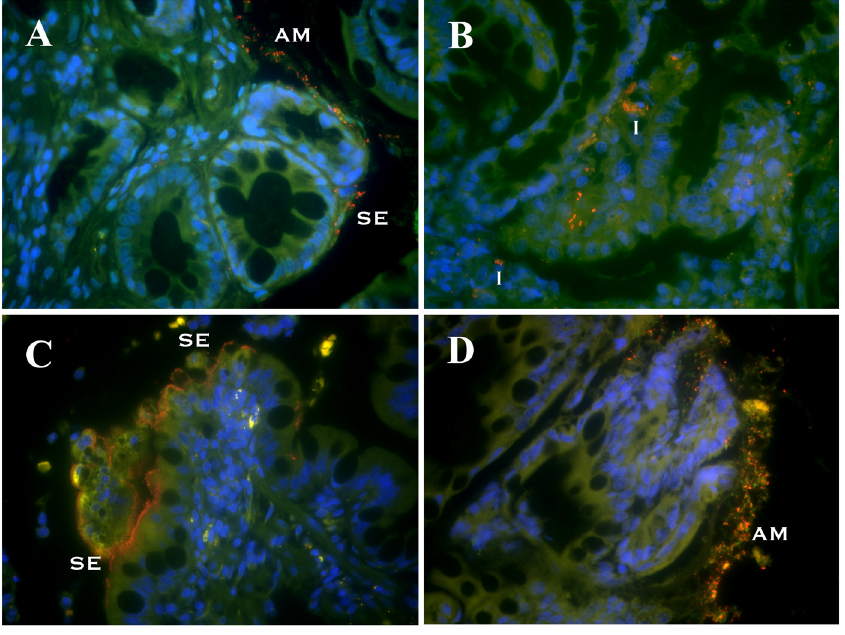
Fig 2. FISH of canine endoscopic biopsies. Triple color FISH identifies bacterial organisms within different mucosal compartments of endoscopic ileal and colonic biopsies obtained from dogs with CE. Panel A = colon biopsy hybridized with Cy3-Erec482; Panel B = colon biopsy hybridized with Cy3-Ec ( E . coli ); Panel C = ileum hybridized with Cy3-Ebac1790; and Panel D = ileum hybridized with Cy3-Bac303. All other bacteria that hybridize exclusively with the universal probe (Eub338-FITC) appear green. DAPI-stained colonic mucosa with goblet cells appears blue. AM = adherent mucus; SE = attached to surface epithelia; I = invasive within